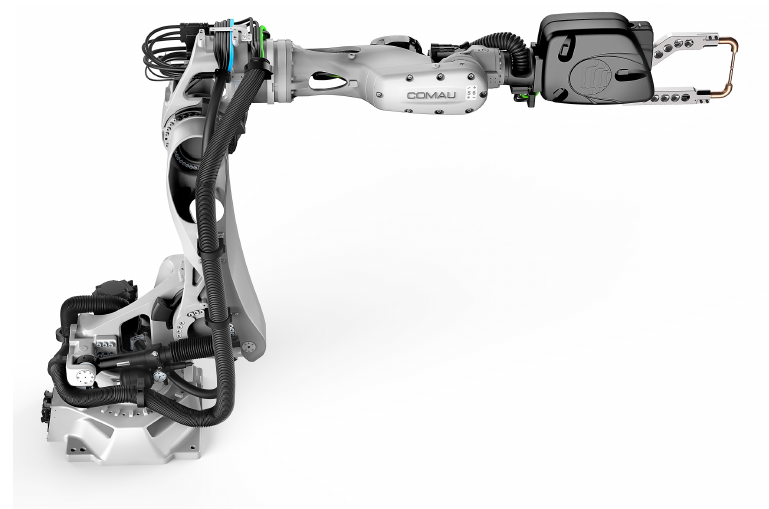
Figure 18. Comau robot